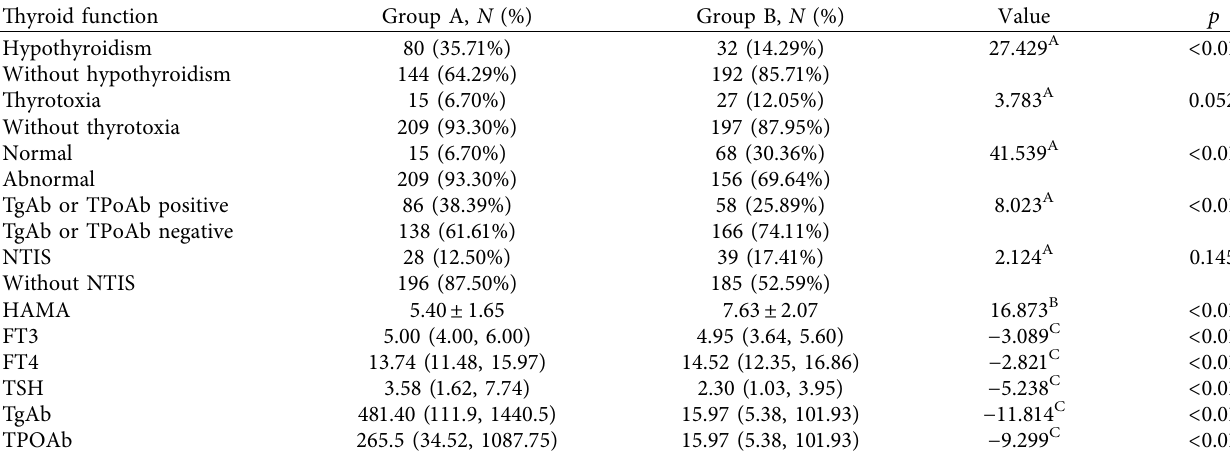
Table 2: Comparison of thyroid function between Group A and Group B.